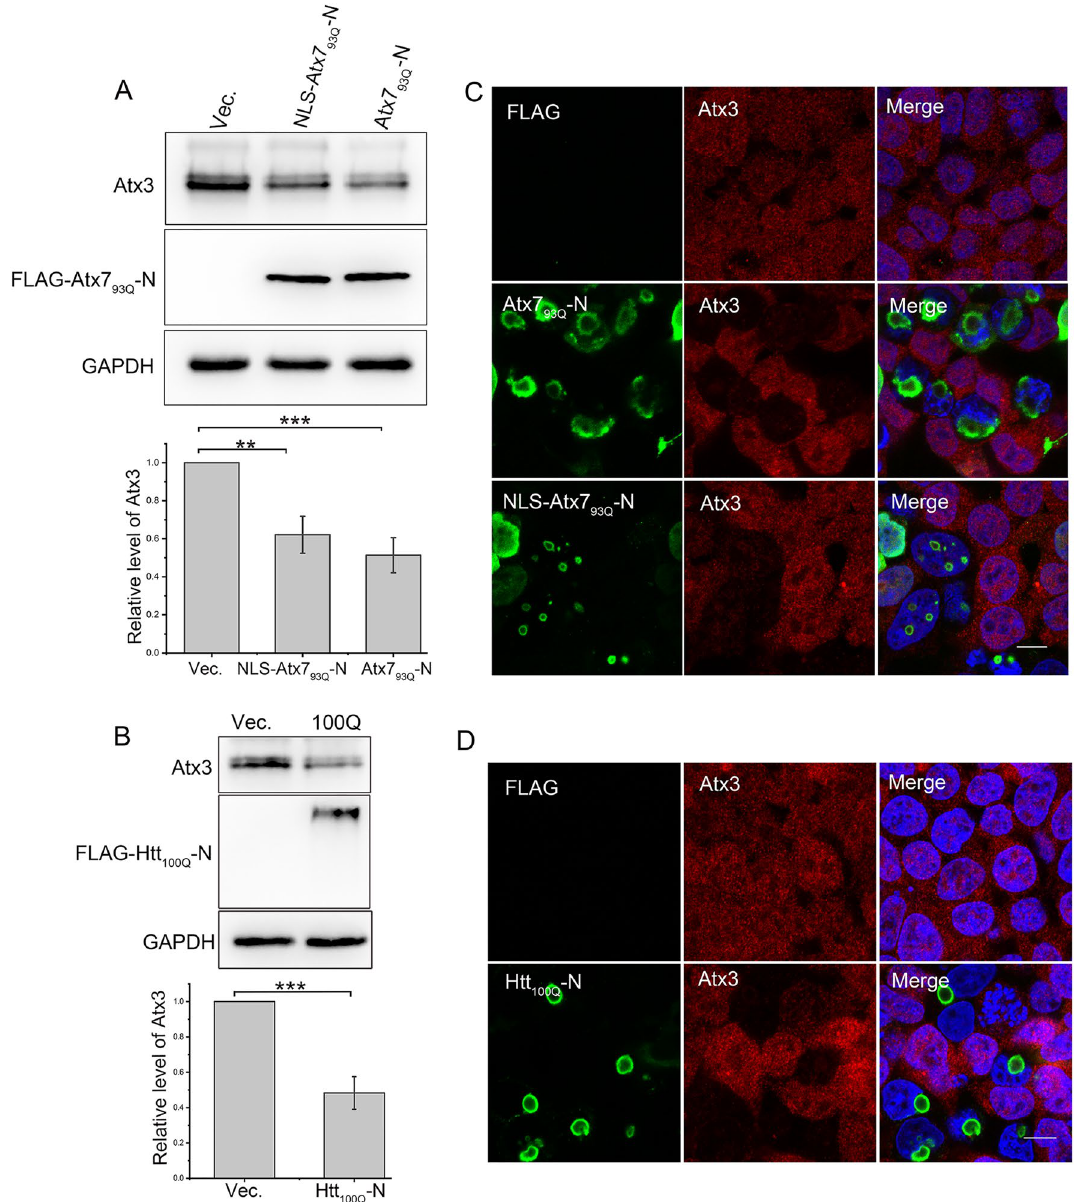
Figure 2. PQE Atx7 and Htt reduce the overall protein level of intracellular Atx3. ( A ) Effect of Atx7 93Q -N172 or NLS-Atx7 93Q -N172 on the overall level of Atx3. ( B ) Effect of Htt 100Q -N90 on the overall level of Atx3. HEK 293T cells were transfected with each indicated plasmid and the total-protein samples were prepared and subjected to Western blotting. Indicated proteins were detected by using anti-FLAG, anti-Atx3 and anti-GAPDH antibodies. Data are shown as Means ± SEM (n = 3). ** p < 0.01; *** p < 0.001. ( C ) Immunofluorescence imaging showing that the cytoplasmic or nuclear Atx7 93Q -N172 inclusions cause fluorescence weakening of the endogenous Atx3. (D) As in (C), Htt 100Q -N90. HEK 293T cells were transfected with each indicated plasmid and then subjected to immunofluorescence staining and confocal microscopic imaging. PolyQ proteins were stained with anti-FLAG antibody (green), Atx3 was stained with anti-Atx3 antibody (red), and nuclei were stained with Hoechst (blue). Scale bar = 10